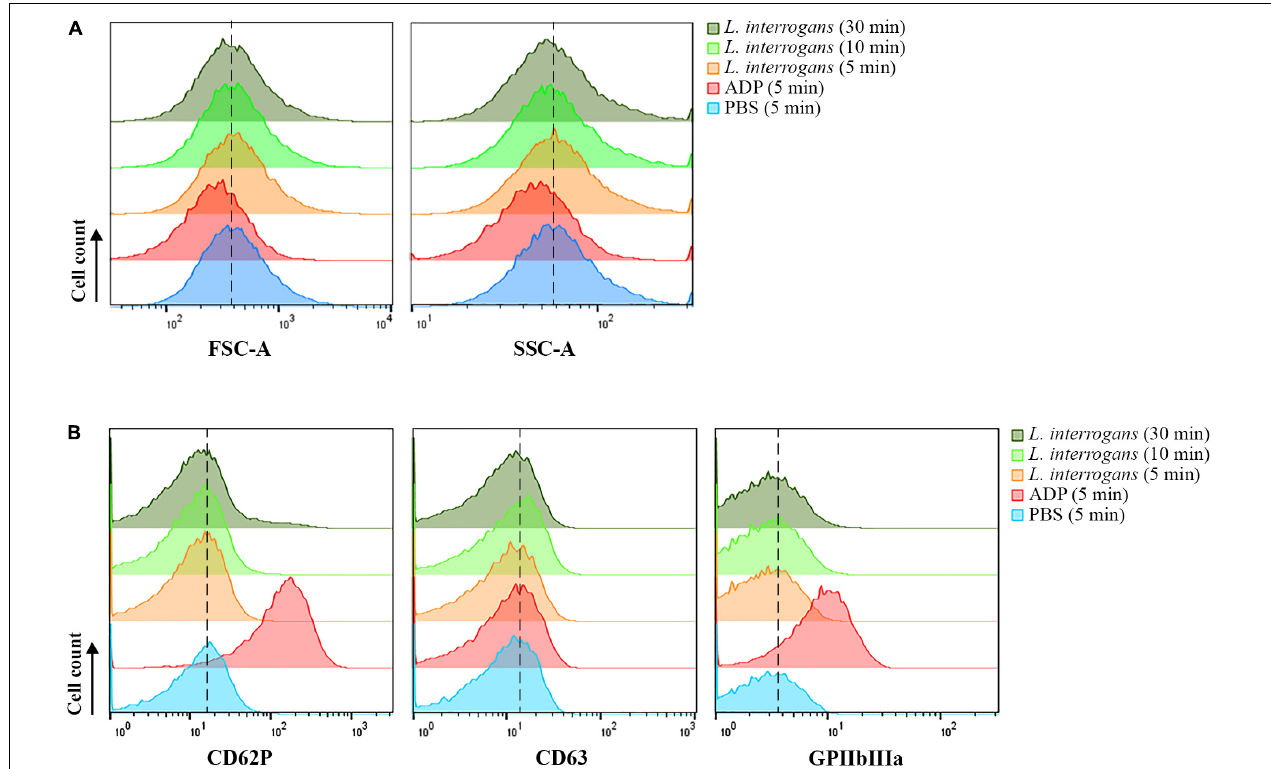
FIGURE 1 | Flow cytometry analysis of platelets in PRP submitted to different stimuli. Platelets in PRP were incubated with the addition of PBS (negative control) or ADP (positive control) for 5 min, or virulent leptospires (2 × 10 6 /mL) for 5, 10 or 30 min. Platelets were marked with CD41a-APC and the results represent only the platelet gate. (A) SSC and FSC profiles of the CD41a-positive population. (B) CD62P (P-selectin), CD63, or activated GPIIbIIIa detection on the membrane of the CD41a-positive gate, respectively. The data are representative of four independent experiments, with four different healthy blood donors. For each sample, 20,000 events were collected. The dashed line was included to aid in the interpretation of the histogram displacement.